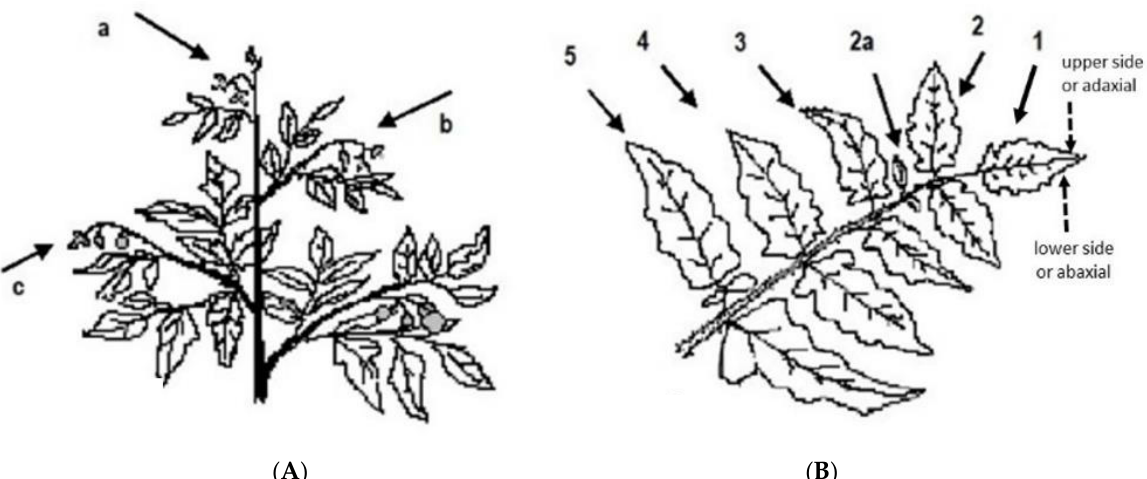
Figure 1. Location of eggs on plant: ( A ) position of leaves a, b, and c on the plant, and ( B ) of leaflets 1, 2, 3, 4, and 5 (the small intermediate leaflets were counted as part of the anterior fully developed leaflet, e.g., eggs on 2a were counted as on leaflet 2) [27].